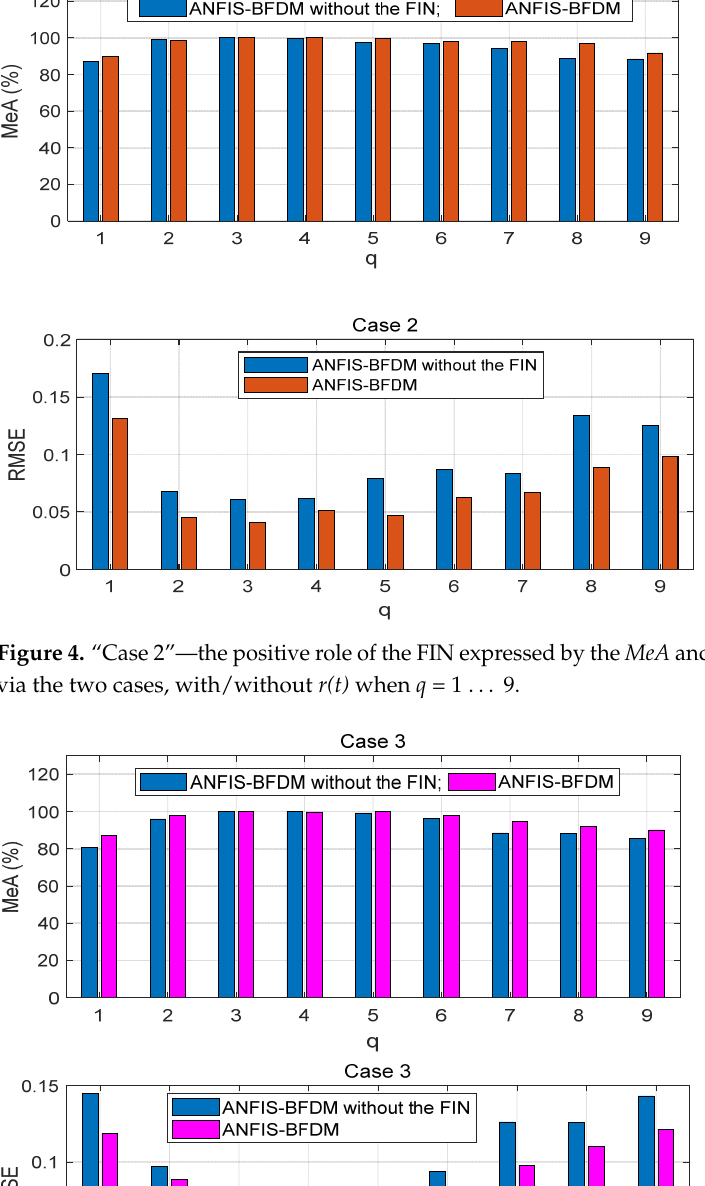
Figure 3. Deriving from the dataset ”Case 1” (see Table 2)—the positive role of the filter FIN re ‐ flected via the MeA and RMSE of the ANFIS ‐ BFDM in two cases, with/without r(t) when q (in Equa ‐ tion (16)) verifying from 1 to 9.